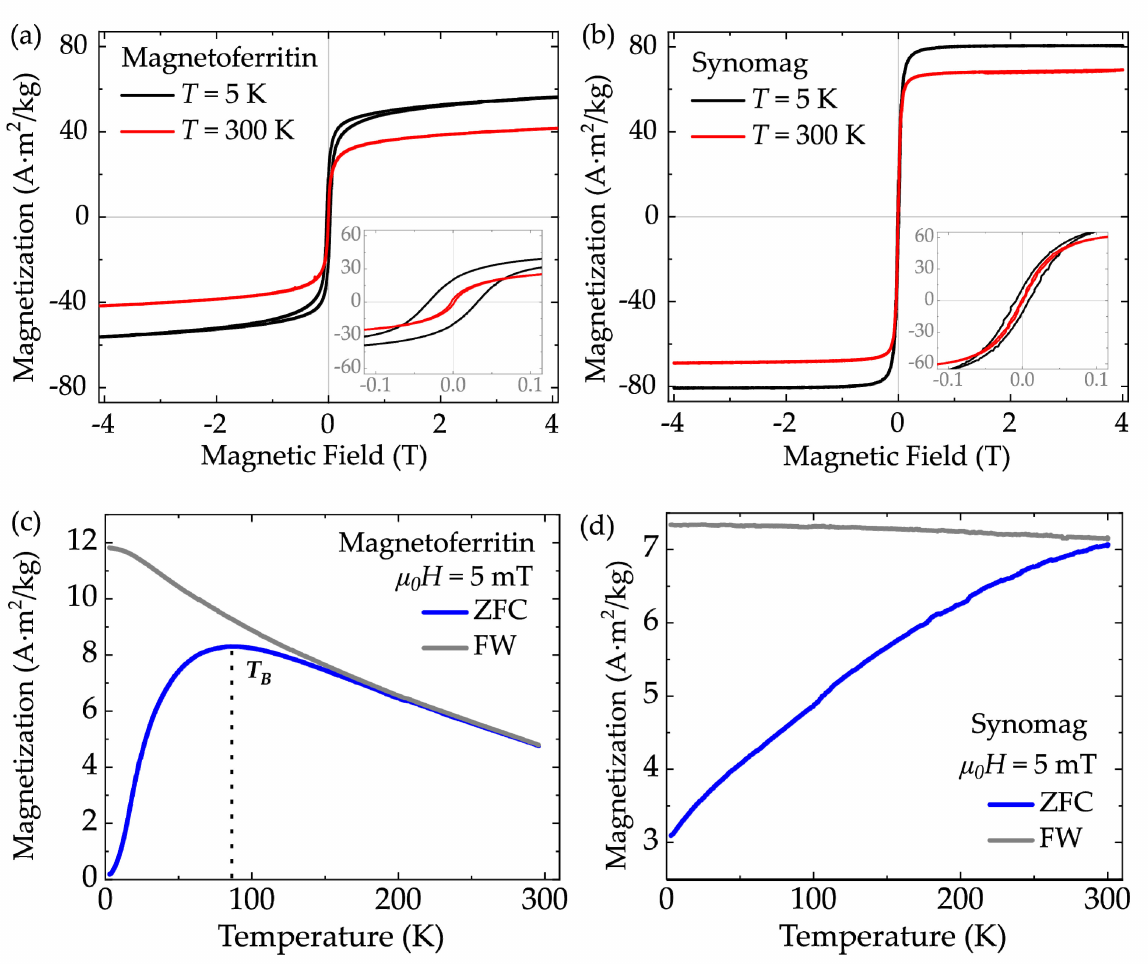
Figure 2. Magnetization as function of magnetic field for ( a ) magnetoferritin and ( b ) synomag nanoparticles. ZFC/FW for ( c ) magnetoferritin and ( d ) synomag measured in 5 mT. T B = characteristic blocking temperature, ZFC = zero field cooling, FW = field